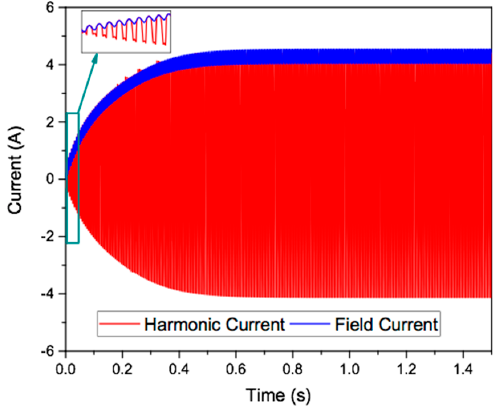
Figure 10. Rotor currents for the proposed brushless WRSM.